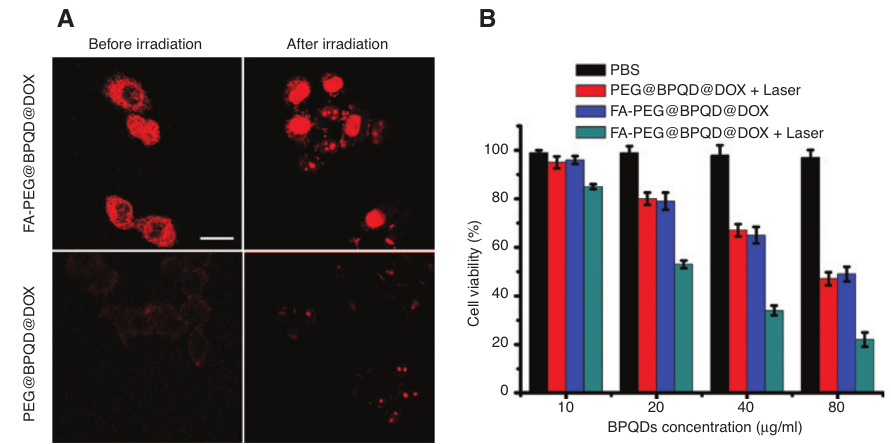
Figure 4: In vitro imaging and anticancer effect of FA-PEG@BPQD@DOX drug delivery platform. The confocal microscopy of 293T cells treated with (A) FA-PEG@BPQD@DOX and PEG@BPQD@DOX. The bar in A is 20 μ m. (B) The cell viability after incubation with BPQDs-based NPs with 808-nm laser irradiation (1 W/cm 2 , 15 min).